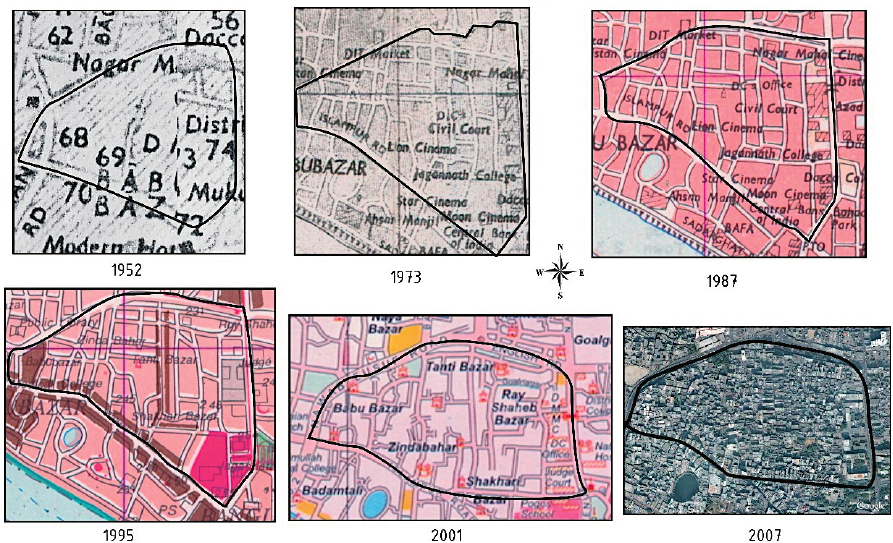
Figure A4. Base maps of ward 72 (Old Dhaka) for syntactic analysis (not to scale). Source: Survey of Bangladesh and Google Earth Image,